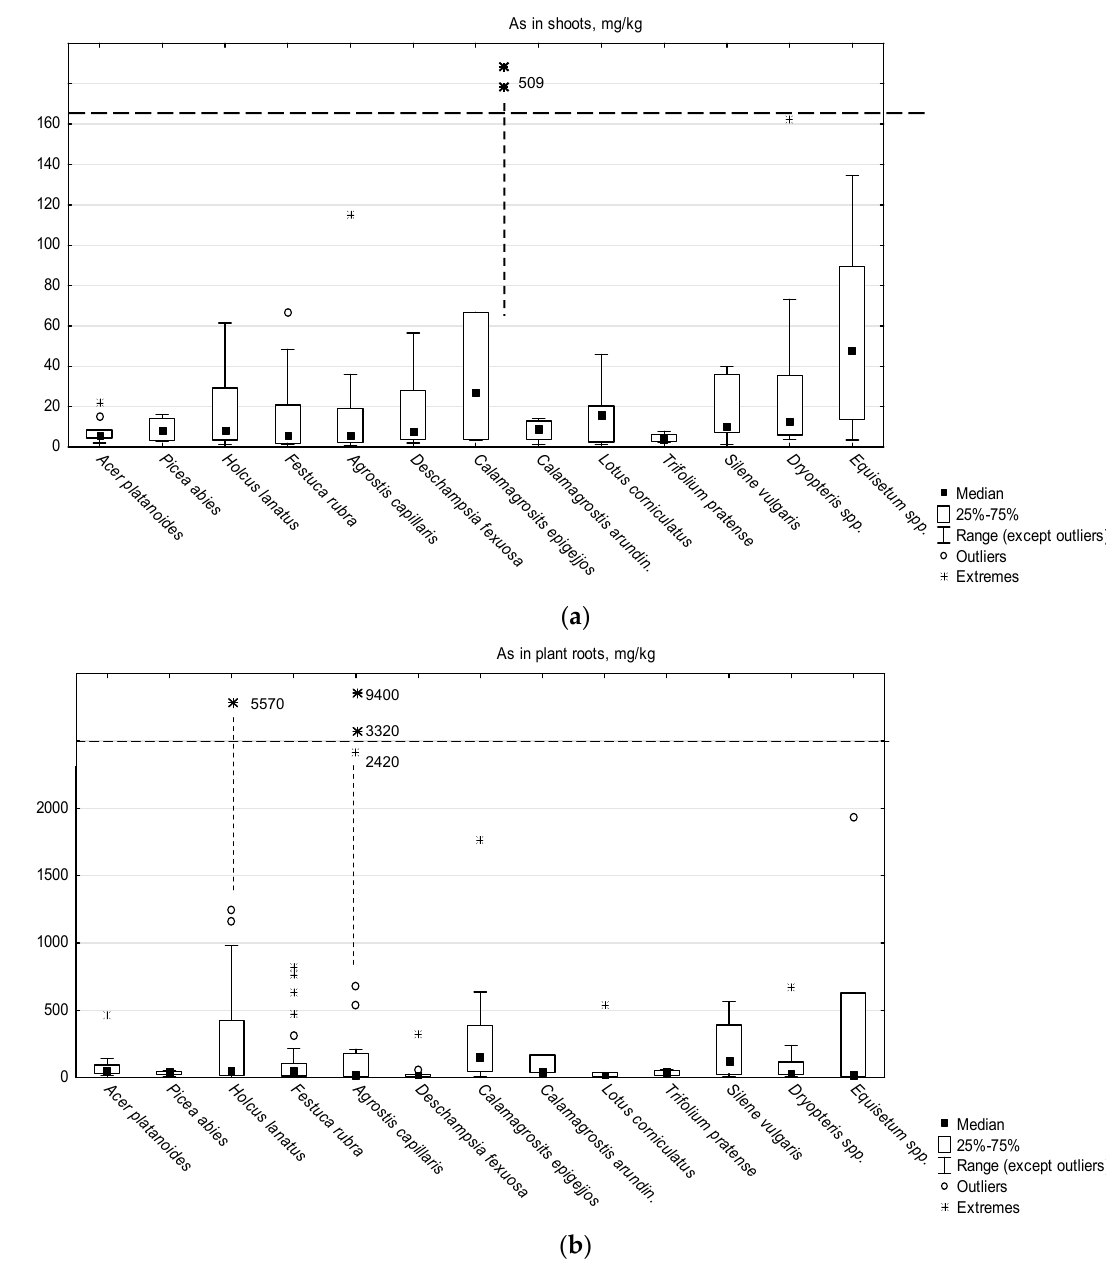
Figure 1. Arsenic concentrations in shoots ( a ) and roots ( b ) of plant species examined.